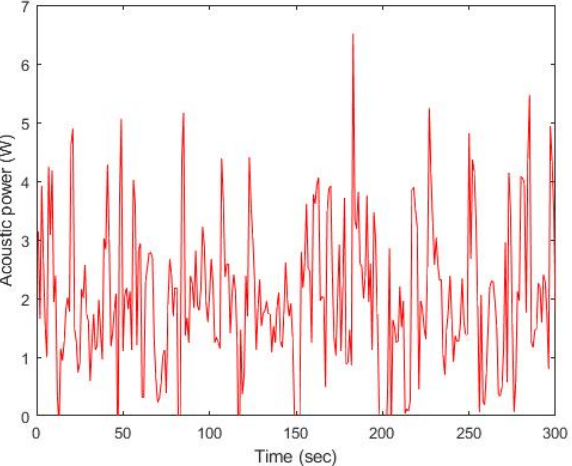
Figure 10. Temporal acoustic power in the case of 100 V PP excitation.